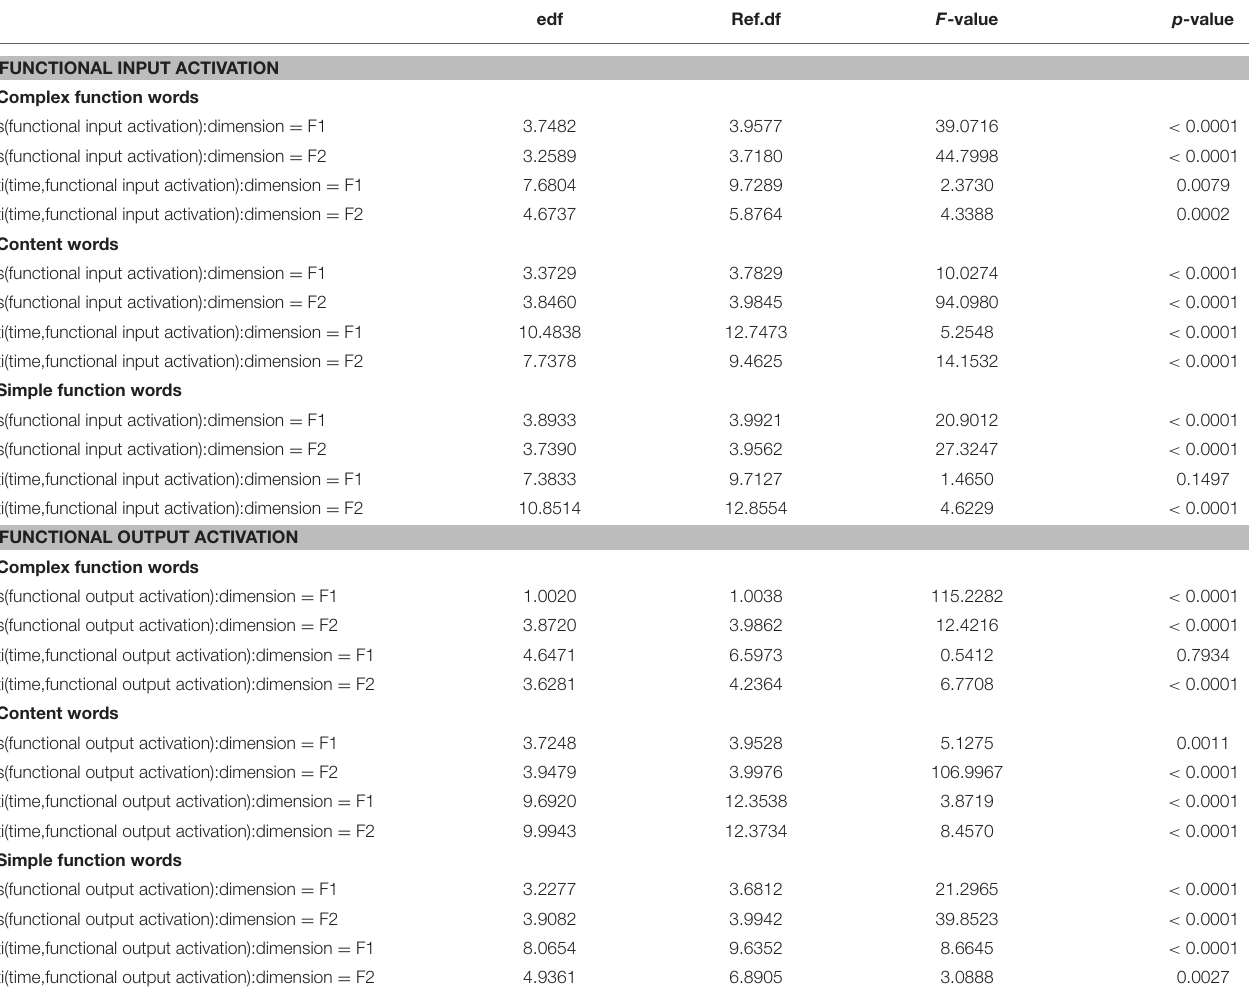
TABLE 1 | Summary of the statistical models using functional input activation and functional output activation as a predictor of formant